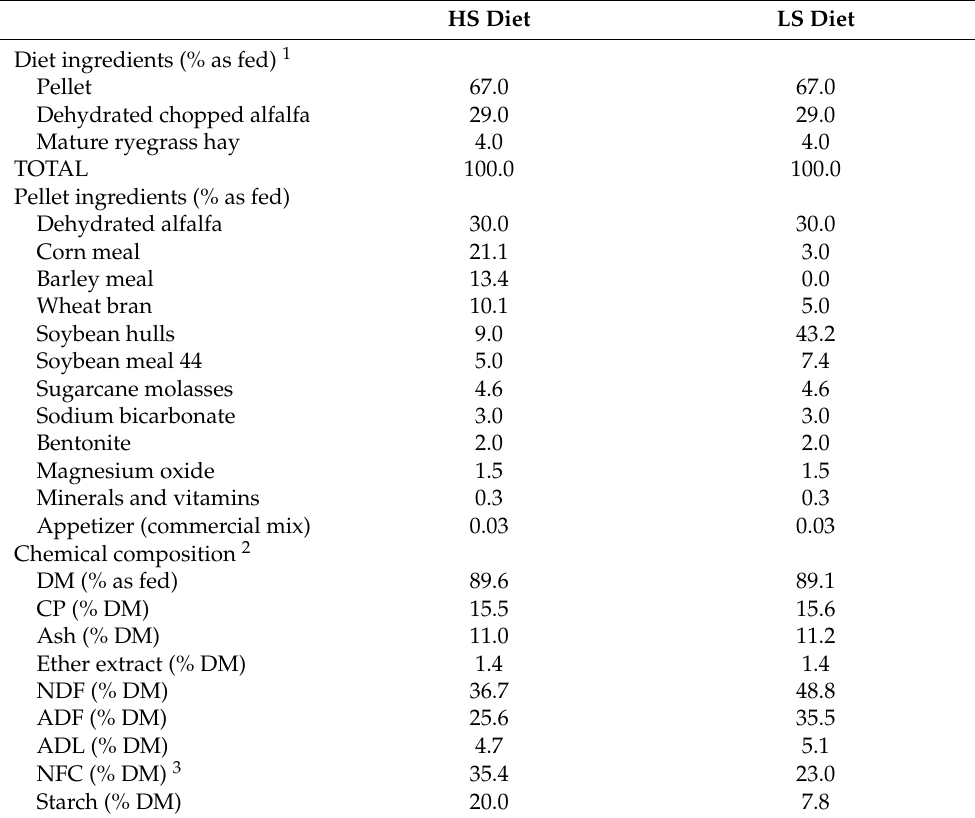
Table 1. Ingredients and chemical composition of the high-starch and low-starch diets supplied during the